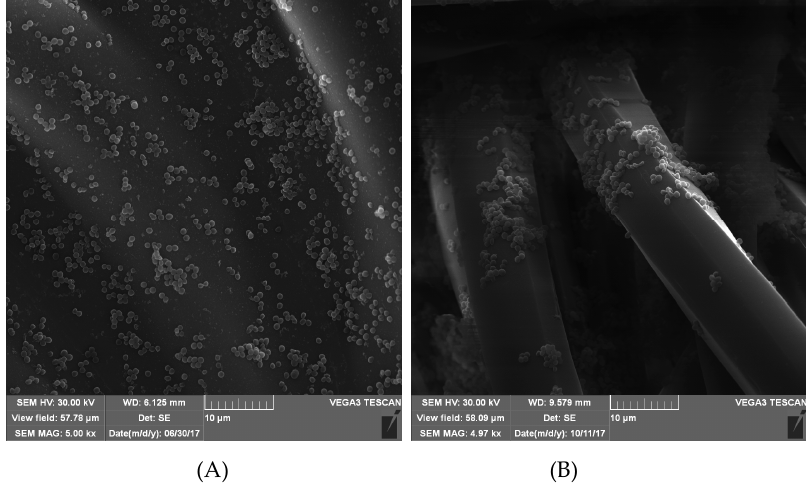
Figure A2. SEM photomicrographs of the Uni-Graft prosthesis surface ( A ) modified with α 1 -AT and ( B ) unmodified, after incubation with Staphylococcus aureus cells. Table A1. Characteristics of parameters describing the morphological structure of the biomaterials surface.